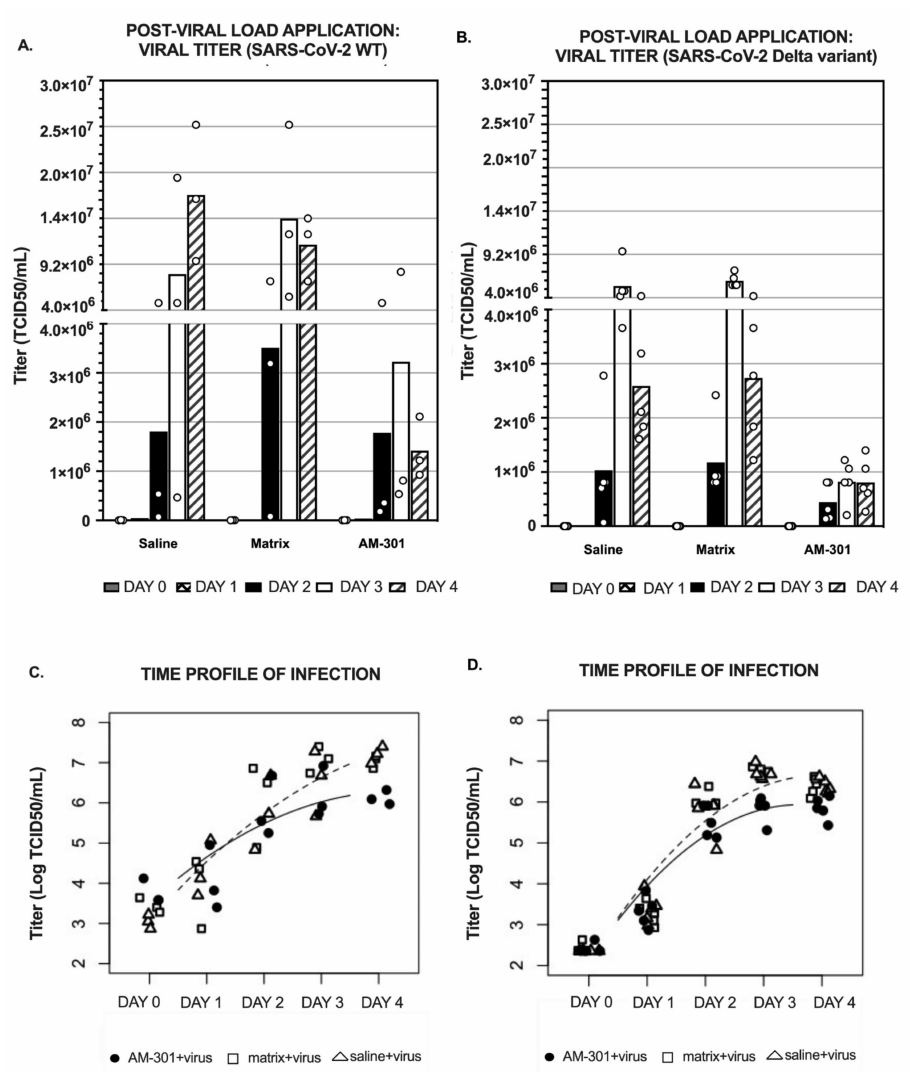
Figure 3. AM-301 as mitigation (post-viral load application) of SARS-CoV-2 infection. Test substances were applied 24 h after the start of the experiment. ( A ) Bar charts with mean values and